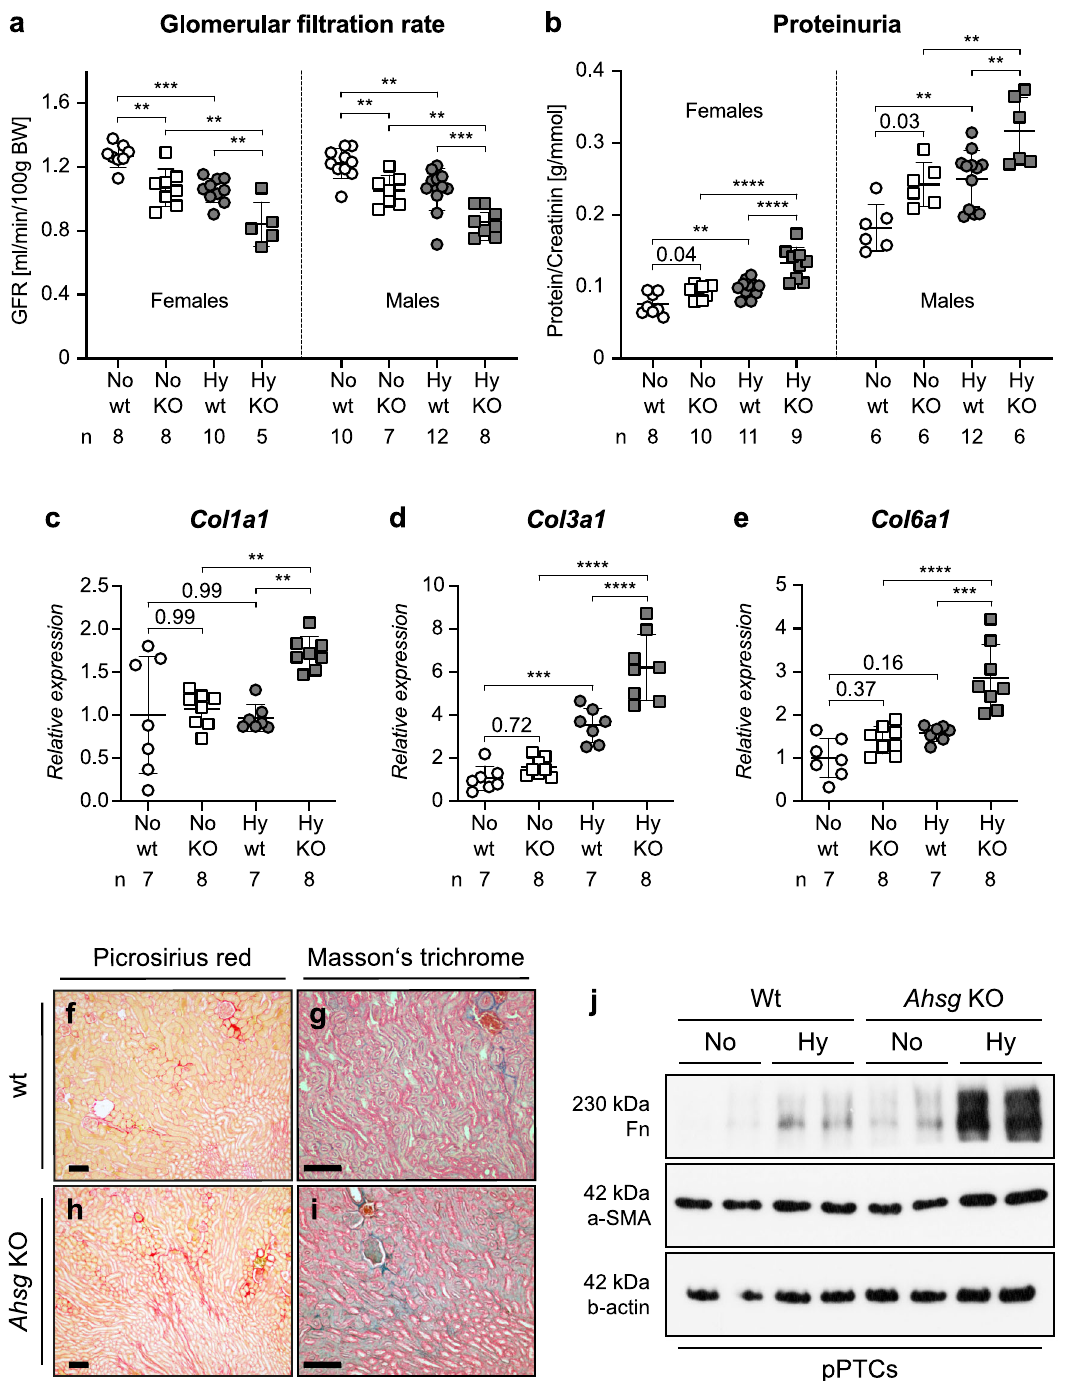
Fig. 5 Fetuin-A de fi ciency aggravates CKD progression in hypoxic IUGR kidneys. a , b Decline of renal function in adult hypoxic offspring showed additive effects of hypoxia and fetuin-A de fi ciency. The decline in GFR was indistinguishable between the sexes with the greatest functional reduction in hypoxic Ahsg KO animals ( a ). The incline in proteinuria (protein/creatinine ratio) was more pronounced in males than in females. For both sexes, hypoxic Ahsg KO animals had the highest ratios ( b ). Male and female samples are analyzed separately. c – e Relative mRNA expression levels of Col1a1 ( c ), Col3a1 ( d ), and Col6a1 ( e ) were markedly enhanced in kidneys of hypoxic Ahsg KO offspring. f – i Histological depiction of collagen using picrosirius red ( f , h ) or Masson ’ s trichrome staining ( g , i ) showed a stronger, more intricate pattern on kidney sections of hypoxic Ahsg KO offprings compared to controls. Images are representative of at least three independent experiments. Scale bar = 100 µ m. j Primary proximal tubular cells (pPTCs) isolated from two different wt or Ahsg KO mice exhibit enhanced expression of fi bronectin and α -smooth muscle actin ( α -SMA) protein upon culture in hypoxic conditions. Images are representative of three independent Western blots. Uncropped blots in Source Data. Data were analyzed from N = hypoxic or normoxic offspring and are presented as mean ± SEM ( a – e ). Ordinary one-way ANOVA with Dunnett ’ s multiple comparisons test ( a – b ) or Ordinary one-way ANOVA with Tukey ’ s multiple comparisons test ( c – e ). Individual P -values are denoted above the comparison lines ( b , c , e ). (**** P < 0.0001; *** P < 0.001; ** P < 0.01). Source data are provided as a Source Data fi